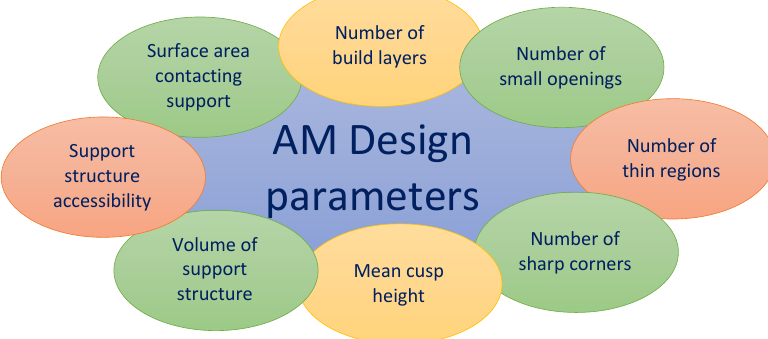
Figure 6. Design parameters considered in the optimization model for build orientation used in